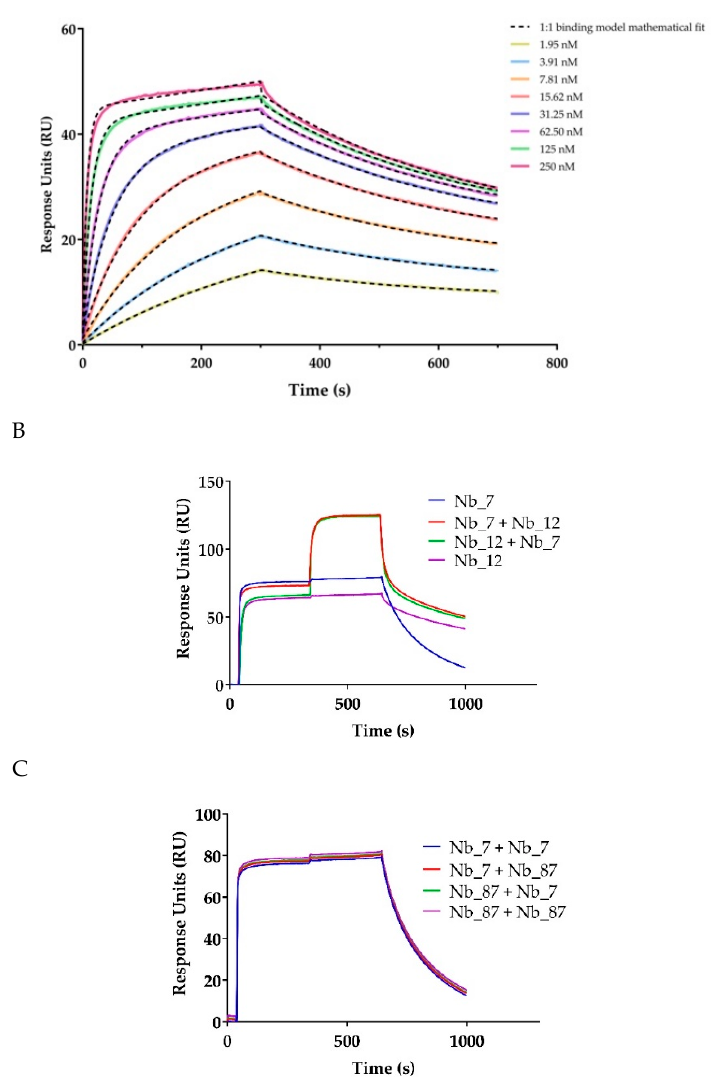
Figure 4. SPR sensorgram of Nb_12 on the CD33 ectodomain and epitope binning by SPR: ( A ) sensorgram of different concentrations (as indicated in the graph) of anti-CD33 Nb_12 binding to biotinylated recombinant human CD33 ectodomain. Kinetics were measured with a two-fold dilution series of Nbs (250–1.95 nM). The fitting of the binding curves using the 1:1 binding mathematical model calculated a K D of 3.9 nM. ( B , C ) Examples of a noncompetitive (independent) and a competitive (overlapping) epitope binding of two Nbs for the same antigen, respectively.